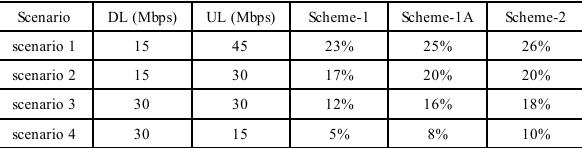
Table 1. DL/UL TP (Mbps) scenarios - respective gains (reduction in download